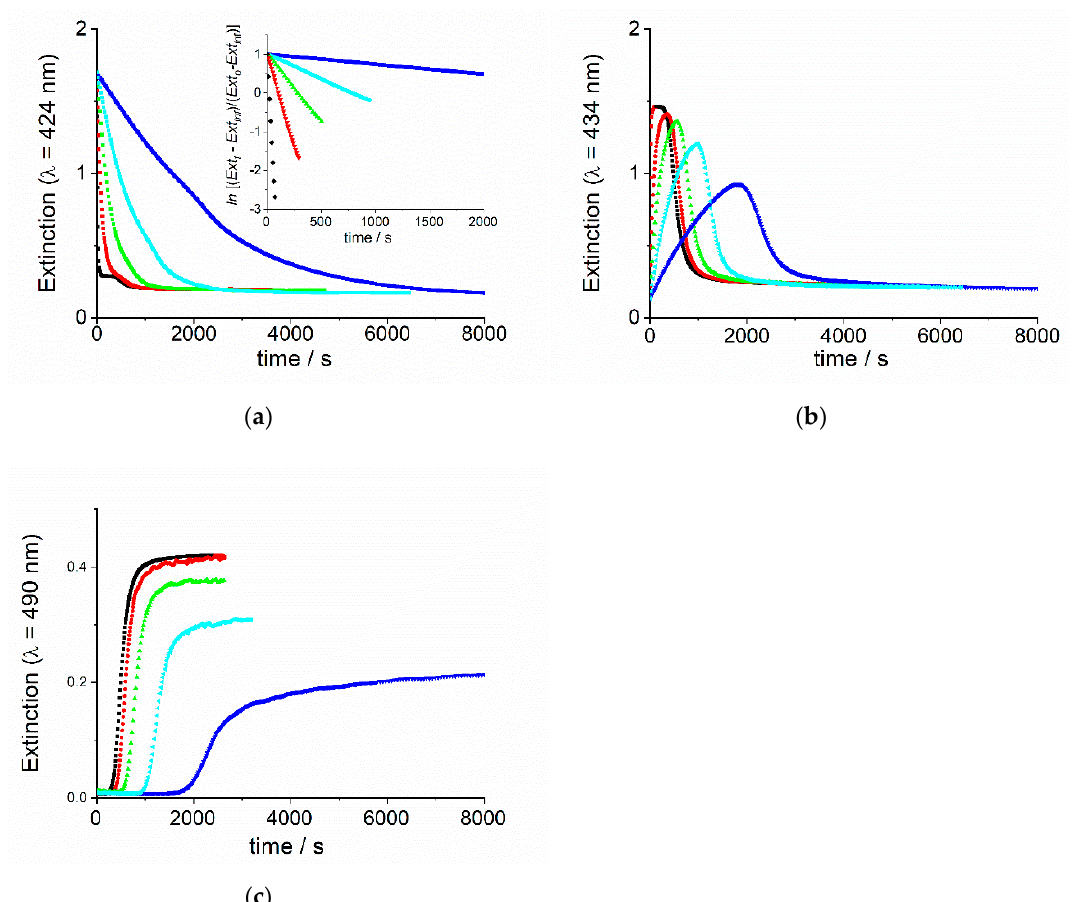
Figure 2. Extinction time traces for kinetic experiments on demetallation of ZnTPPS 4 at constant ionic strength and different acid concentrations: ( a ) at 422 nm (in the inset the semilogarithmic plots according to a first order rate law are reported); ( b ) at 434 nm and ( c ) at 490 nm. (Experimental conditions: [ZnTPPS 4 ] = 3 μ M; [H 2 SO 4 ] = 0.01 (blue), 0.02 (cyan), 0.03 (green), 0.05 (red) and 0.1 M (black), IS = 0.6 M by ZnSO 4 , T = 298 K).